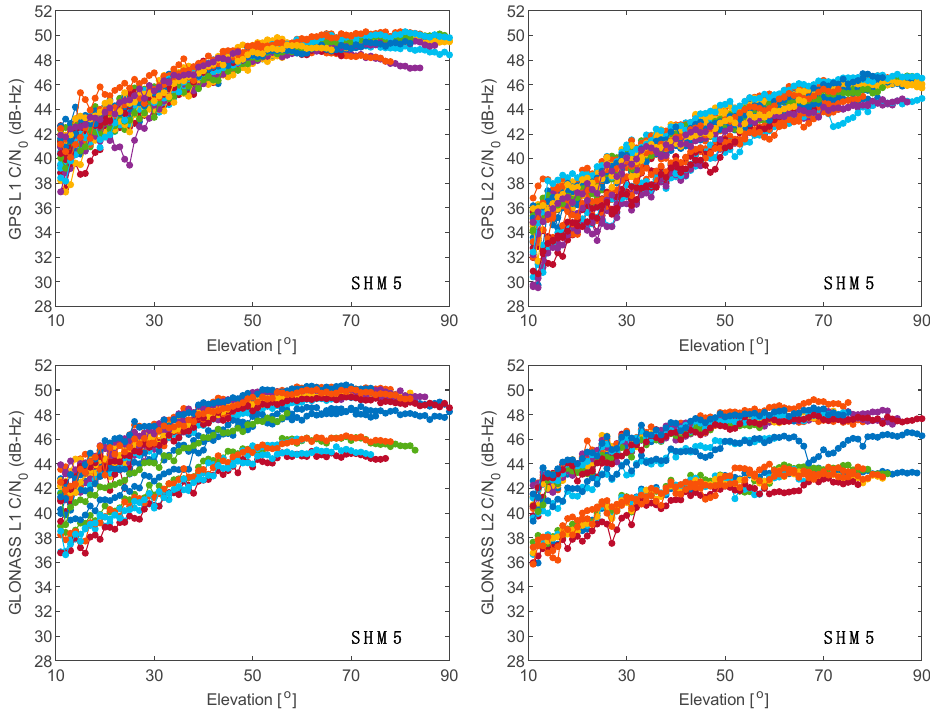
Figure 5. GPS and GLONASS SNR average value within one elevation versus elevations at site SHM5.